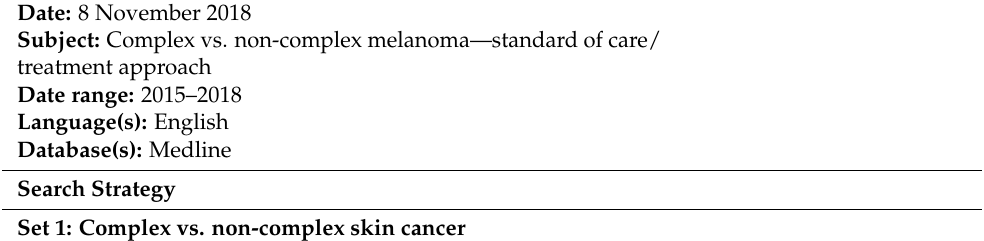
Table A1. Search strategy for the systematic literature